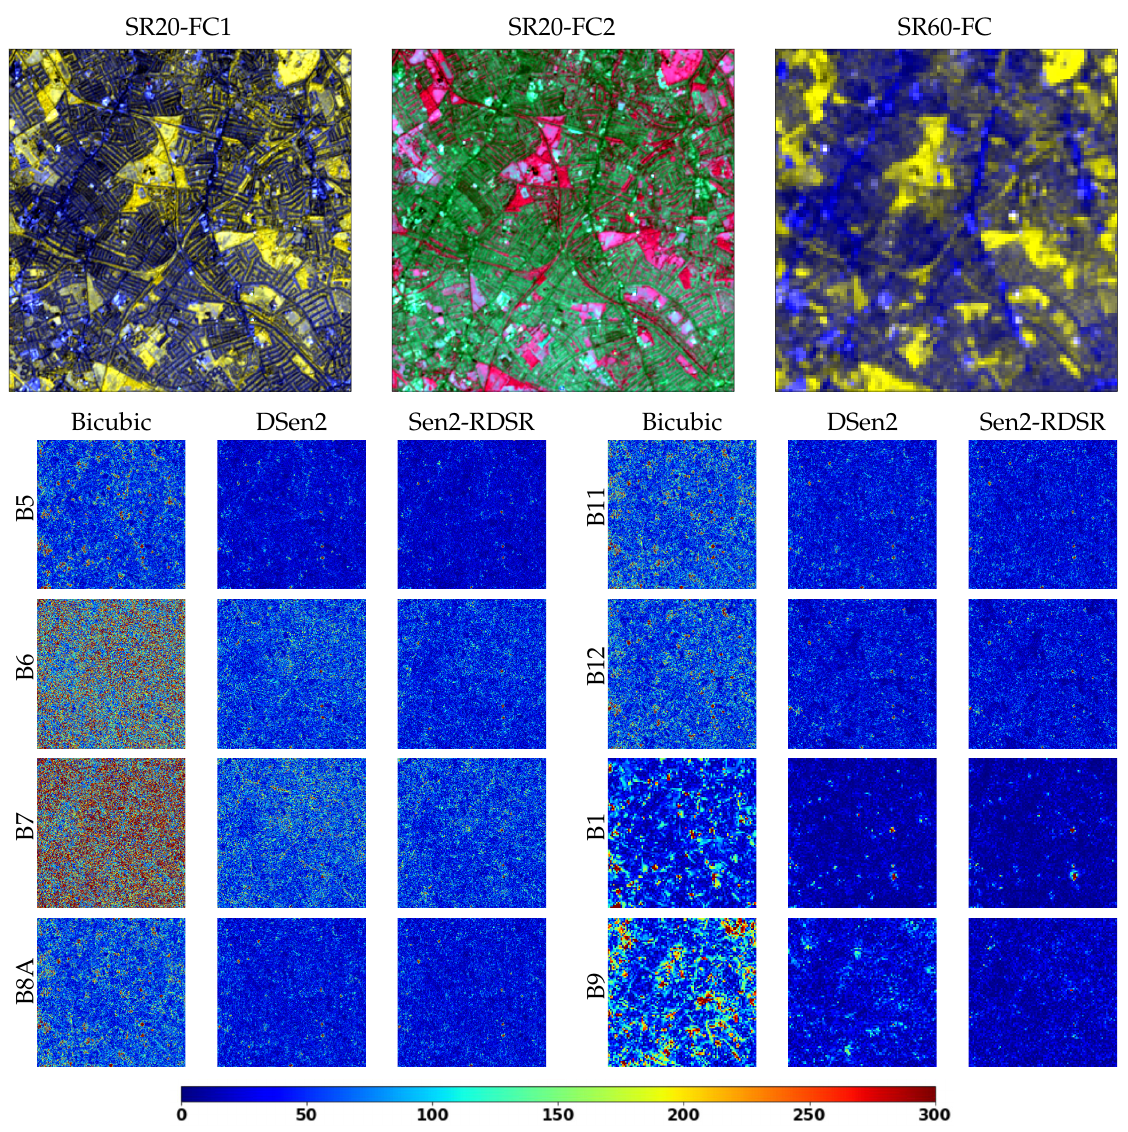
Figure 6. Comparison of the absolute difference between the target and the SR image per band. A small region of 100 × 100 pixels was selected to show the difference between the models. The first row shows the false color composite for SR20 FC1:{B5,B6,B7}, FC2:{B12,B11,B8A} and SR60 FC:{B9,B9,B1} images. The remaining rows show the error maps for the bicubic interpolation, DSen2 (images were generated from its public GitHub repository), and our